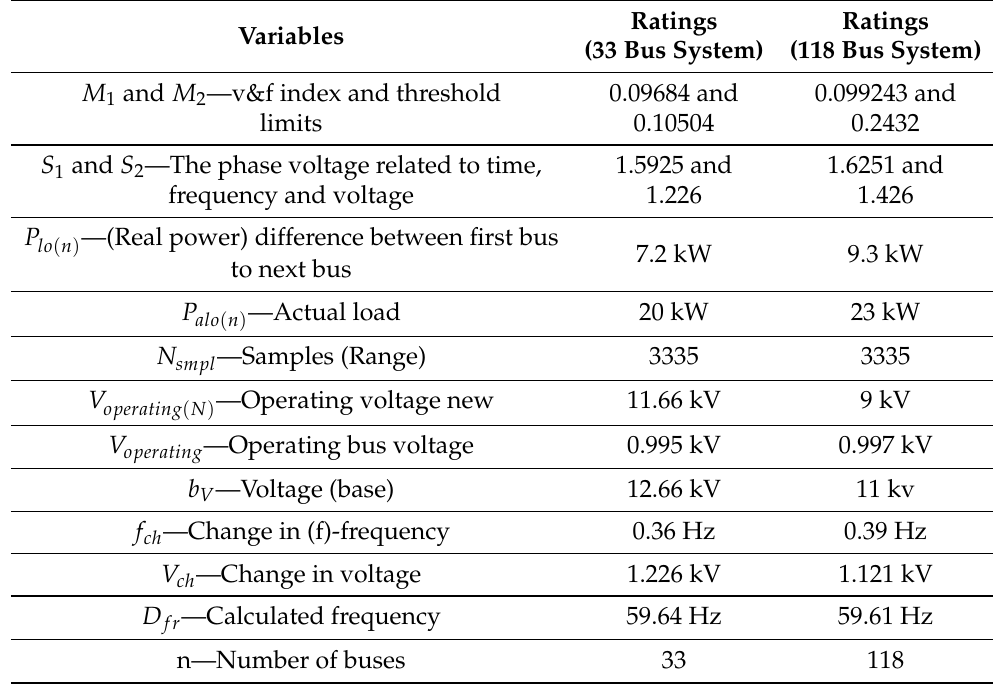
Table 4. Parameters of proposed